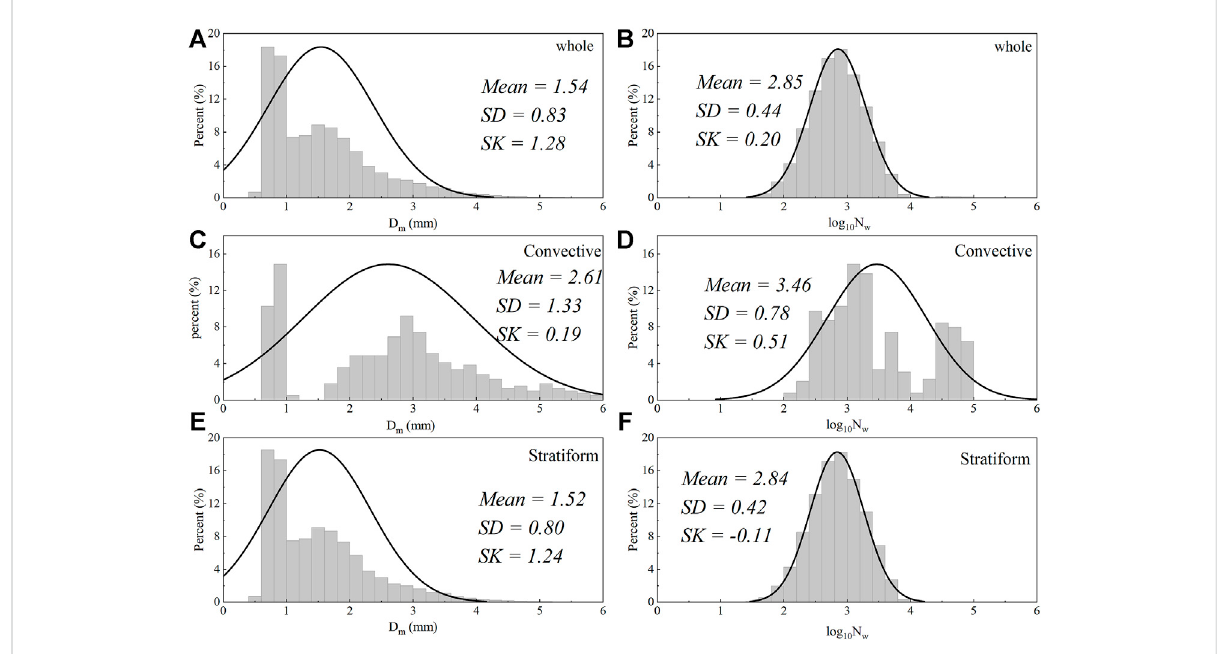
FIGURE 7 Histogram of D m and log 10 N w for the (A,B) whole data set and (C,D) convective and (E,F) stratiform subsets calculated from the PWS100 disdrometer